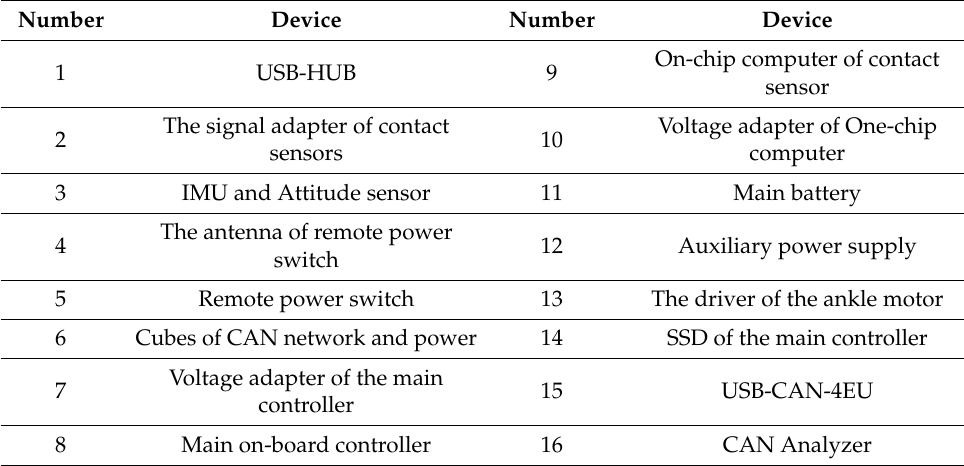
Table 3. On-board